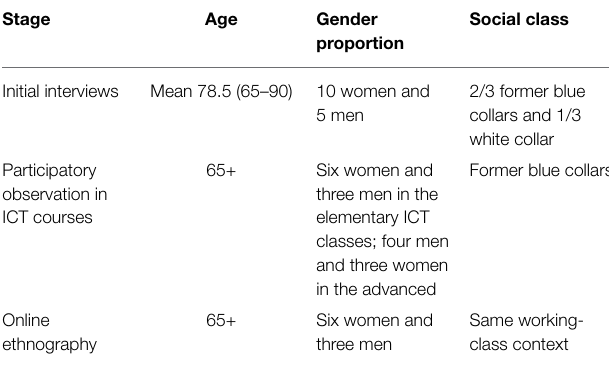
TABLE 1 | Summary of the